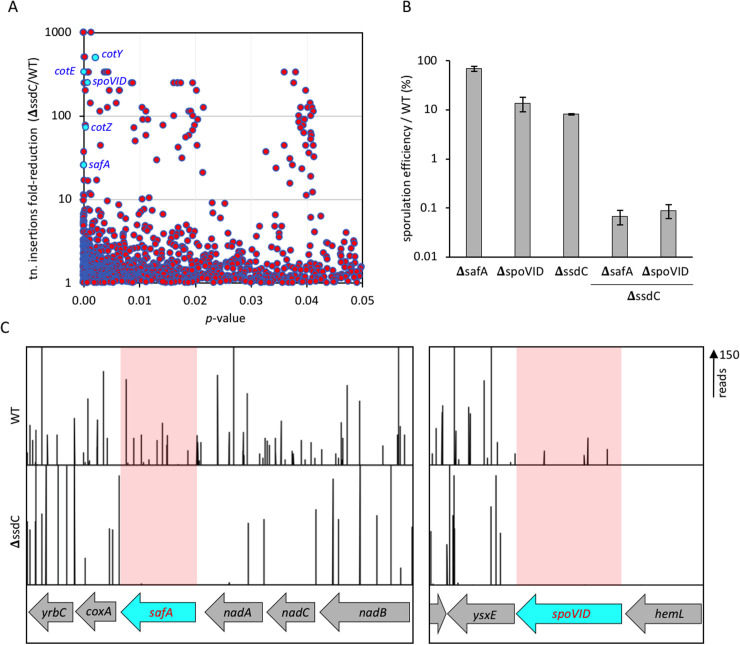
Tn-seq reveals coat genes that are important for sporulation in the absence of ssdC.(A) Scatterplot showing fold-reduction of transposon insertions in ΔssdC (bCR1565) relative to wild-type (WT) cells (BDR2413), with corresponding p-values. Spore coat genes with high fold-reduction in ΔssdC compared to WT cells and low p-value are labelled and coloured cyan. (B) Sporulation efficiency of mutant strains ΔsafA (bBK33), ΔspoVID (bBK3), ΔssdC (bBK28), ΔssdC ΔsafA (bBK48) and ΔssdC ΔspoVID (bBK43) as a percentage of wild-type (BDR2413, WT). Error bars represent standard deviation of three biological replicates. (C) Tn-seq profiles at the safA and spoVID genomic loci of wild-type (BDR2413, WT) and ΔssdC (bCR1565) cells, following 24 h of growth and sporulation in exhaustion medium. Height of vertical lines represents number of transposon-sequencing reads at each position. Shaded regions highlight the significant reduction in sequencing reads at safA and spoVID loci.